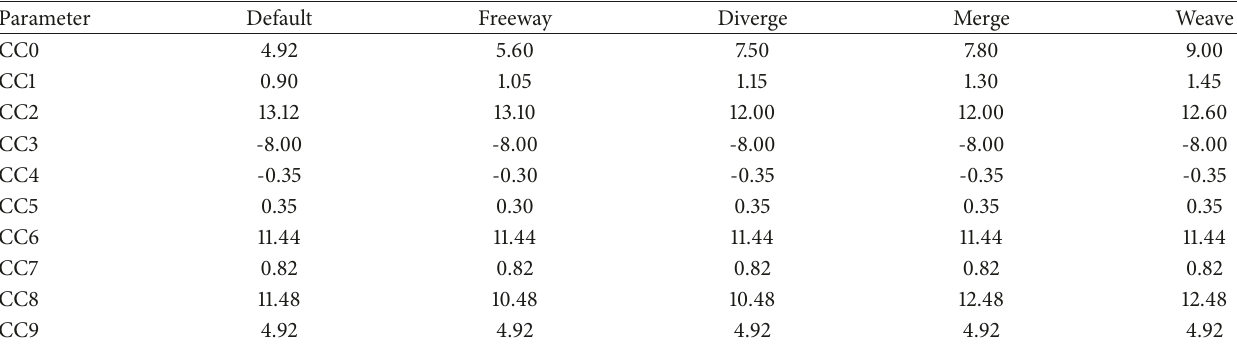
Figure 2: Demand profiles at (a) Cambridge Cr. (b) Lamar Ave. (c) 67 th St. Table 1: Calibrated Wiedemann 99 model